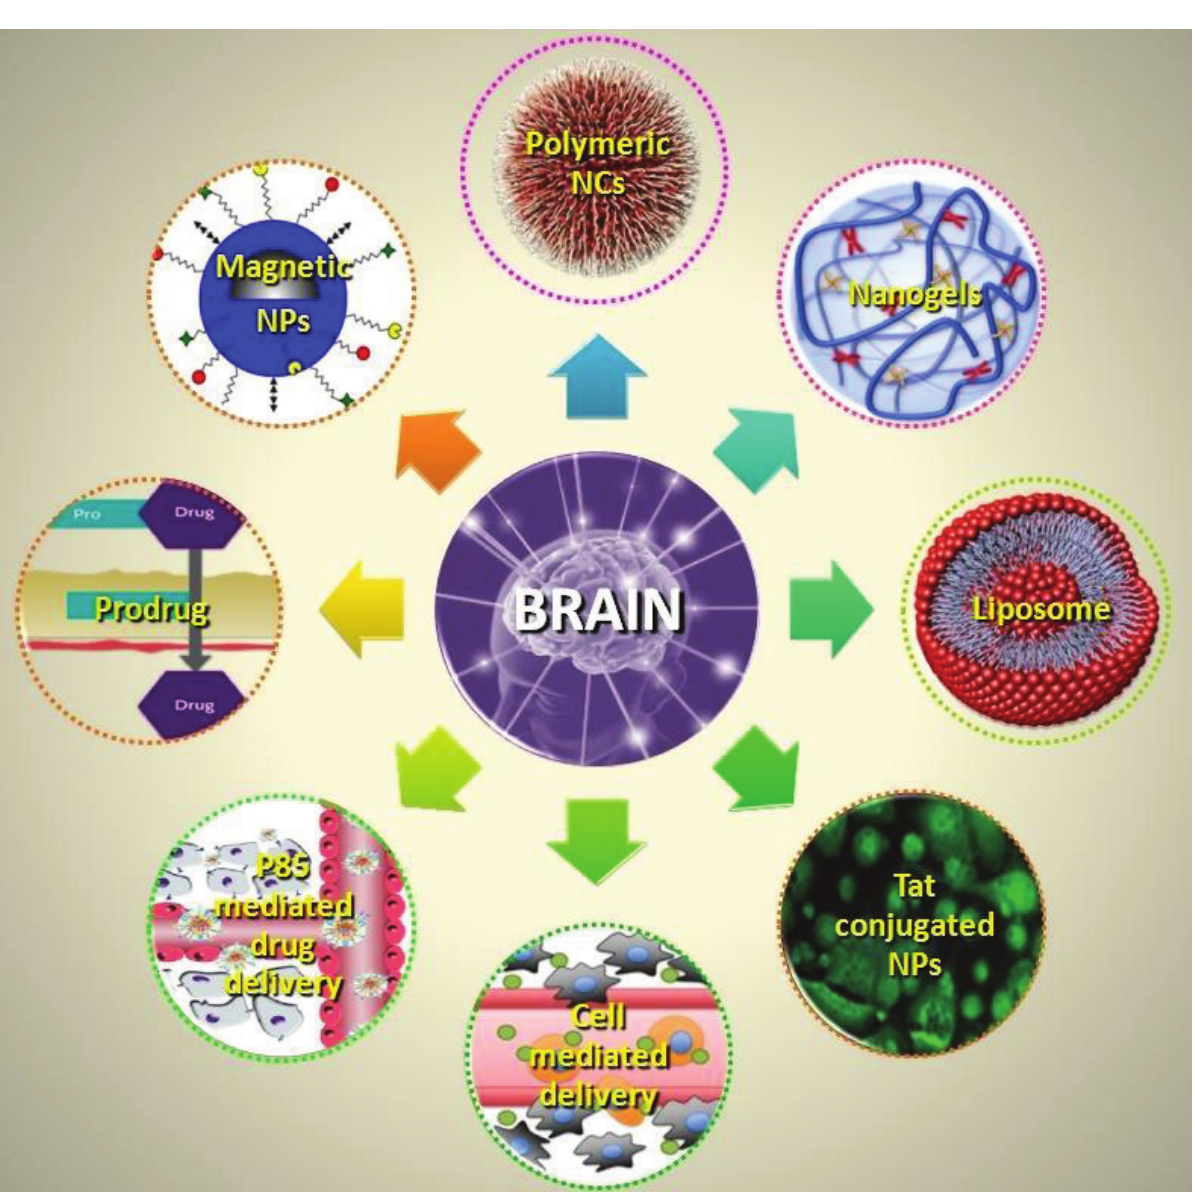
Figure 2: Novel drug delivery approaches for targeting the brain in NeuroAIDS . Novel drug delivery approaches for targeting the brain in NeuroAIDS are Magnetic nanoparticles-based Nanomedicines (3’-azido-3’-deoxythymidine-5’-triphosphate), Polymeric Nanocarriers (lamivudine, stavudine and zidovudine), Nanogels (zidovudine and didanosine), Liposome-based Nanomedicines (zidovudine, zalcitabine and didanosine), Tat conjugated NPs mediated drug delivery (ritonavir), Cell mediated delivery of NPs (ritonavir and efavirenz), P85 mediated drug delivery (lamivudine, zidovudine and nelfinavir) and Prodrug-based approach (tenofovir disoproxil fumarate and